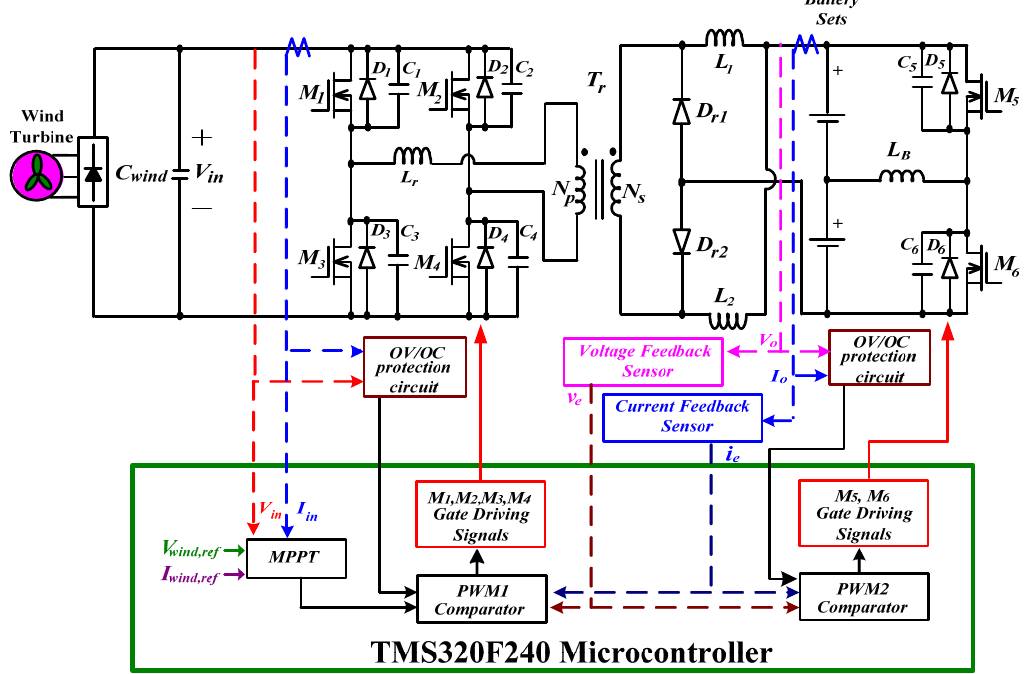
Figure 14. Conceptual control block diagram of the proposed energy storage system for wind energy